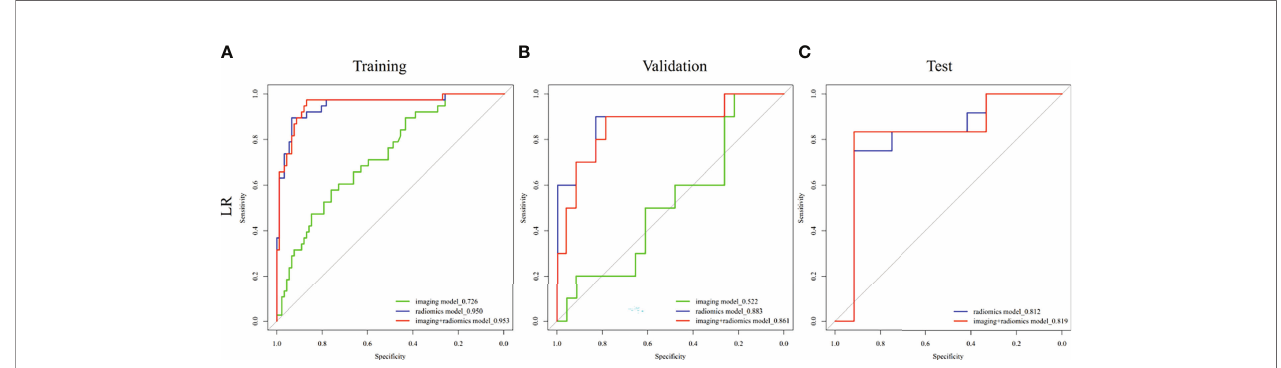
FIGURE 4 | Comparison of receiver operating characteristic (ROC) curves for prediction of MVI in ICC. ROC curves of imaging model constructed with tumor size and intrahepatic duct dilatation, radiomics model constructed with diffusion-weighted image, precontrast T1-weighted image, and delayed phase image, and MVI prediction model constructed imaging model and radiomics model in the (A) training, (B) validation, and (C)